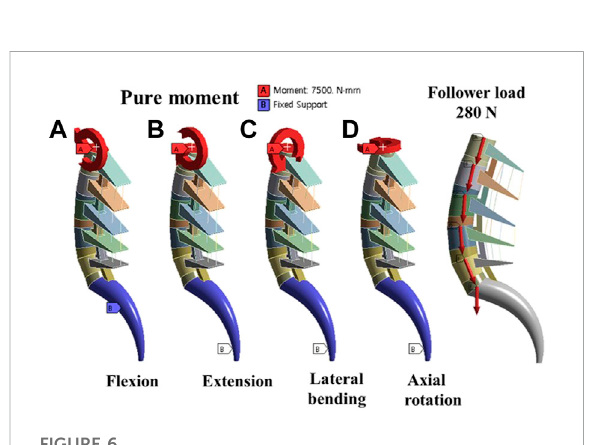
FIGURE 6 Boundary conditions; (A) Flexion motion (B) Extension motion (C) Lateral bending motion (D) Axial rotation motion and Follower load